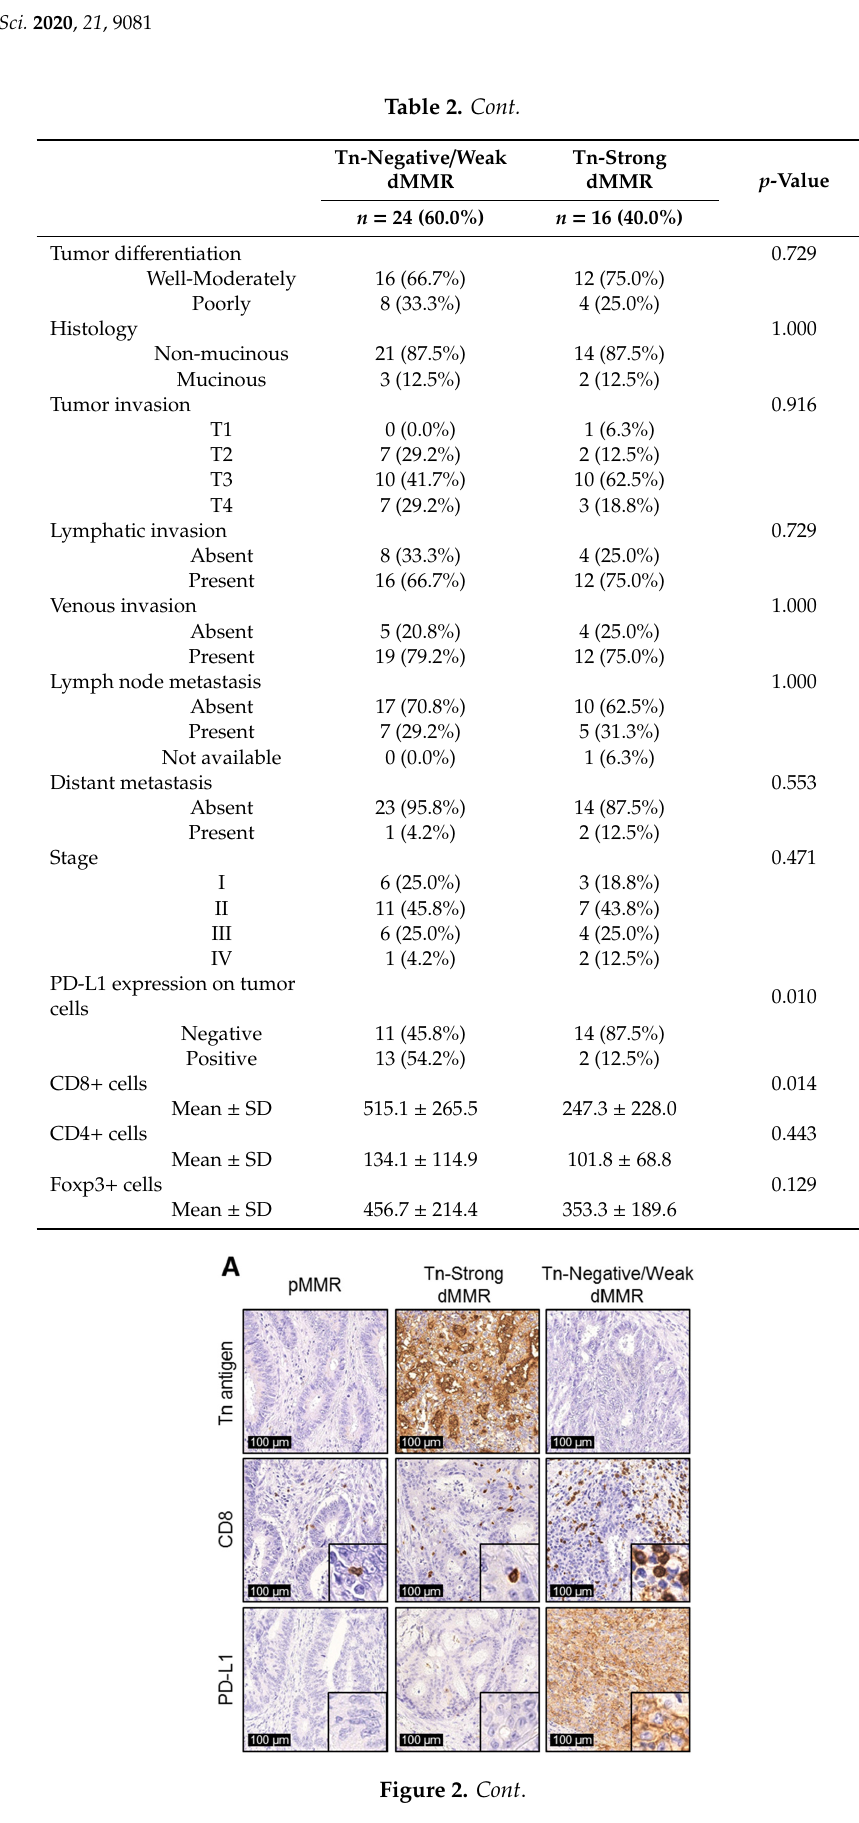
Figure 2. The Tn-strong dMMR subset lacks common immunological characteristics of dMMR tumors, including CD8+ T cell infiltration and tumor cell surface PD-L1 expression. ( A ) Representative immunohistochemistry images for Tn antigen, CD8, and PD-L1 in pMMR, Tn-strong dMMR, and Tn-negative/weak dMMR tumors. ( B , C ) Tn-strong dMMR tumors displaying lower levels of CD8+ T cell infiltration ( B ) and PD-L1 expression ( C ), compared to those of Tn-negative/weak dMMR tumors. **** p < 0.0001, *** p < 0.001, n.s. p > 0.05. 3. Discussion Despite the initial failure of ICIs in pMMR CRC, it has been established that patients with dMMR CRC represent a biomarker-defined subgroup that contains potentially good responders to immunotherapy with ICIs, however, substantial clinical and molecular diversity still exists within this population that may affect ICI treatment response. Indeed, nearly half of metastatic dMMR CRC cases exhibit primary resistance to the current ICIs, potentially due to multiple tumor escape mechanisms [2,8]. Since immunotherapies are expected to be potentiated by combinatorial strategies to overcome immunosuppressive mechanisms, recent advances in the detailed understanding of the TME in CRC have attempted to further stratify dMMR tumors into different subsets, with the final goal of defining the eligibility of patients with dMMR CRC for more personalized immunotherapeutic interventions. For example, higher tumor mutation burden (TMB), CD8+